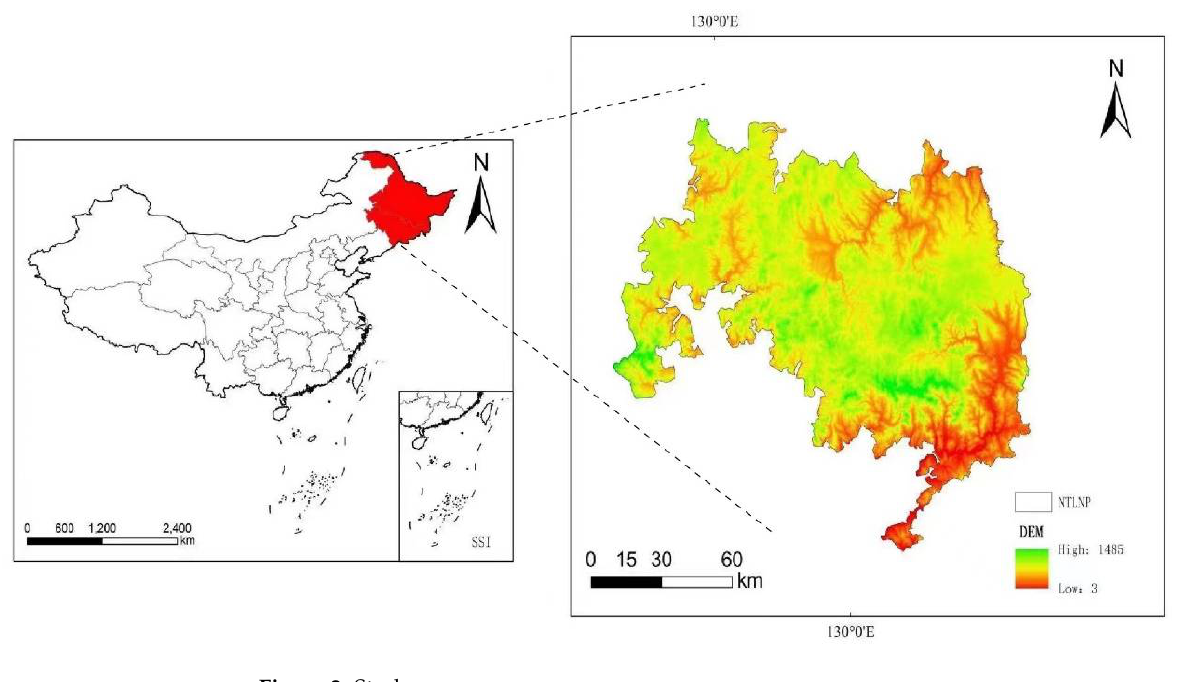
Figure 2. Study area.